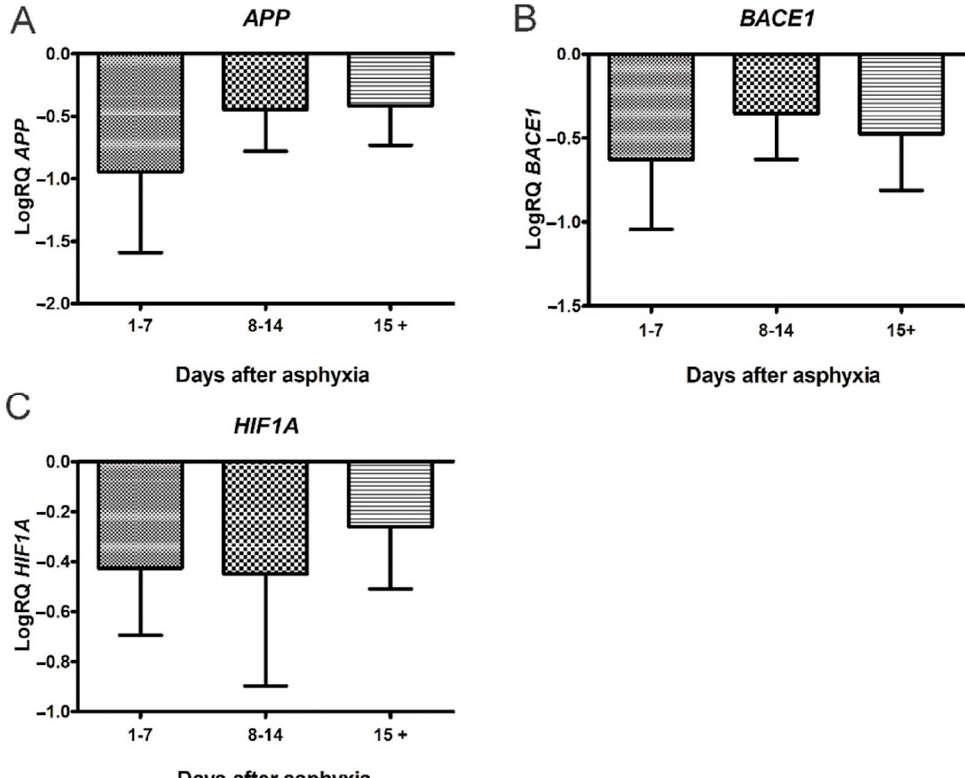
Figure 1. Changes of amyloid protein precursor (APP), β -secretase ( BACE1) and hypoxia-inducible factor 1- α ( HIF1A ) genes after perinatal asphyxia. ( A ) Mean levels of APP gene expression in lymphocytes after perinatal asphyxia in age groups 1–7 (n = 8), 8–14 (n = 7), and 15+ (n = 8) days. Marked SD, standard deviation. N, number of children in the group. The changes between the groups were not statistically significant (Kruskal–Wallis test). ( B ) Mean levels of BACE1 gene expression in lymphocytes after perinatal asphyxia in age groups 1–7 (n = 8), 8–14 (n = 7), and 15+ (n = 8) days. Marked SD, standard deviation. N, number of children in the group. The changes between the groups were not statistically significant (Kruskal-Wallis test). ( C ). Mean levels of HIF1A gene expression in lymphocytes after perinatal asphyxia in age groups 1–7 (n = 8), 8–14 (n = 7), and 15+ (n = 9) days. Marked SD, standard deviation. N, number of children in the group. The changes between the groups were not statistically significant (Kruskal-Wallis test) [3].